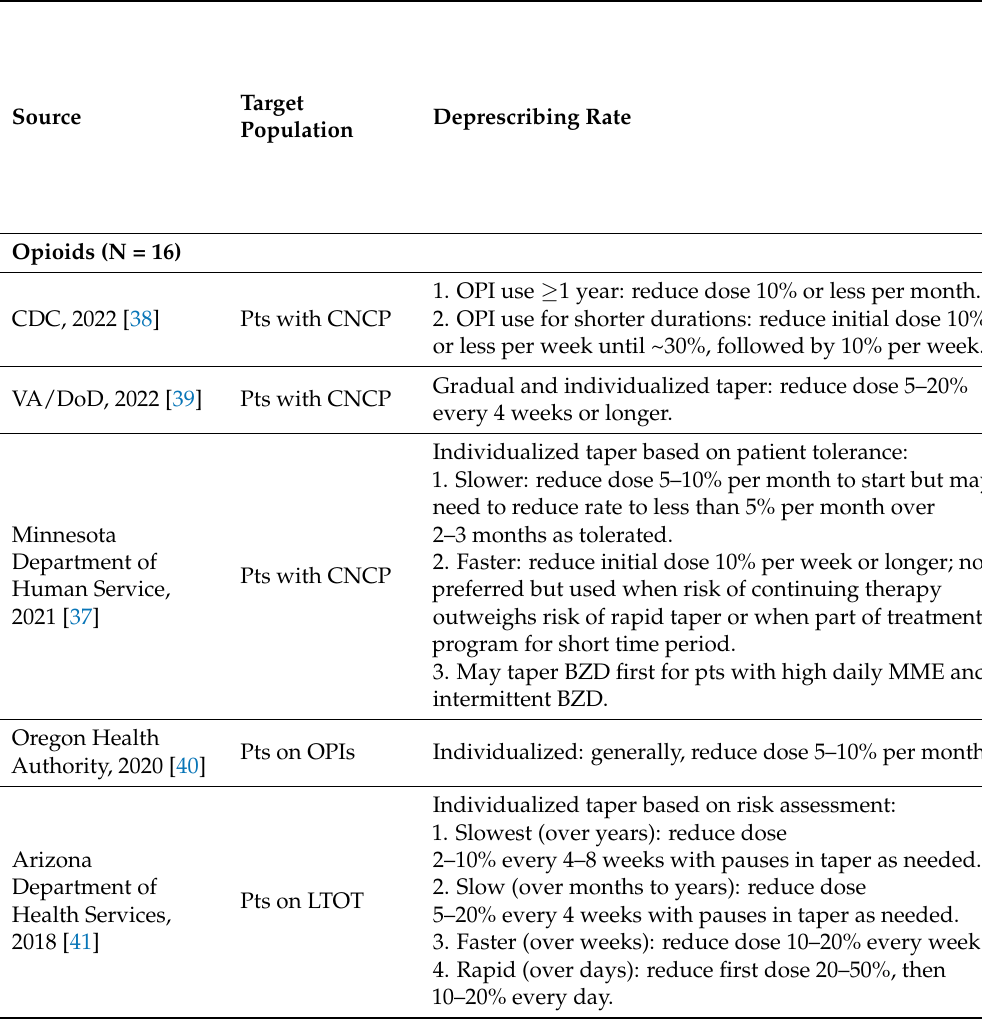
Table 1. Characteristics of unique guidelines and protocols for deprescribing opioids or benzodiazepines.